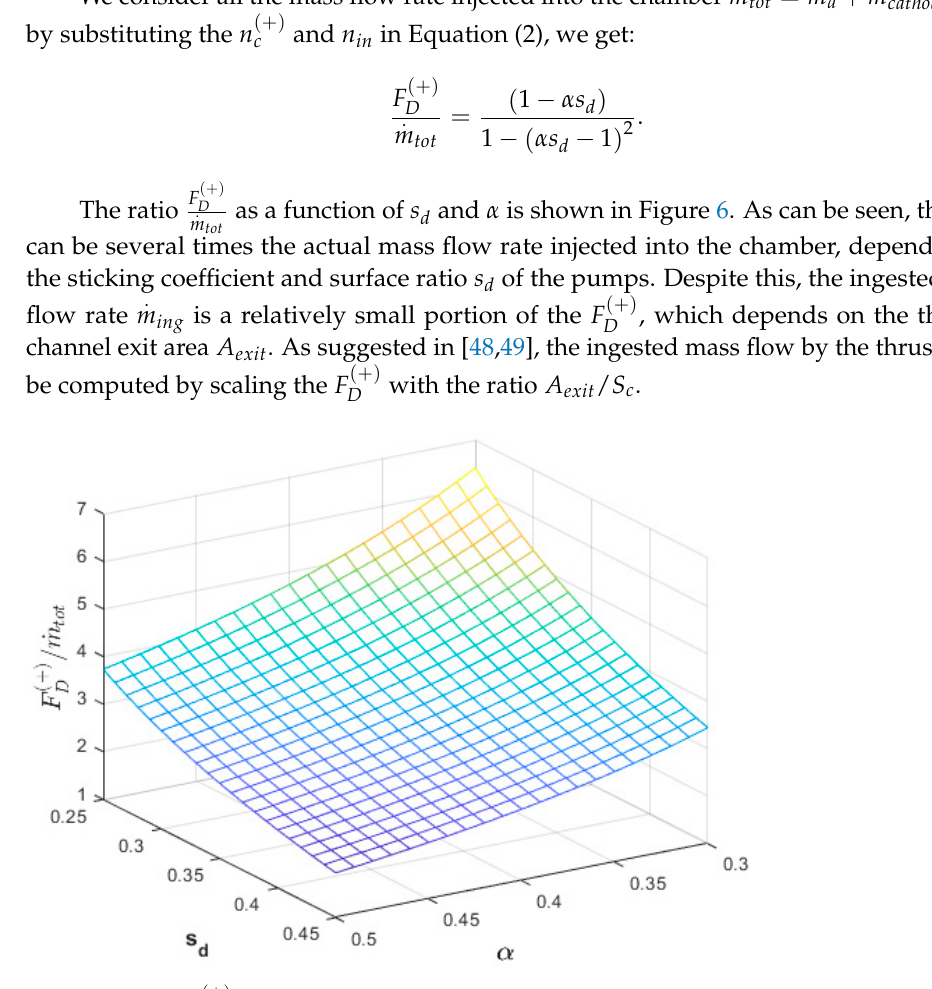
. (+) m tot as a function of the sticking coefficient α and the surface ratio s d for a Figure 6. Ratio F / Figure 6. Ratio 𝐹 (cid:3005)((cid:2878)) / 𝑚(cid:4662) (cid:3047)(cid:3042)(cid:3047) as a function of the sticking coefficient 𝛼 and the surface ratio 𝑠 (cid:3031) for a D vacuum chamber equipped only with downstream vacuum chamber equipped only with downstream pumps.